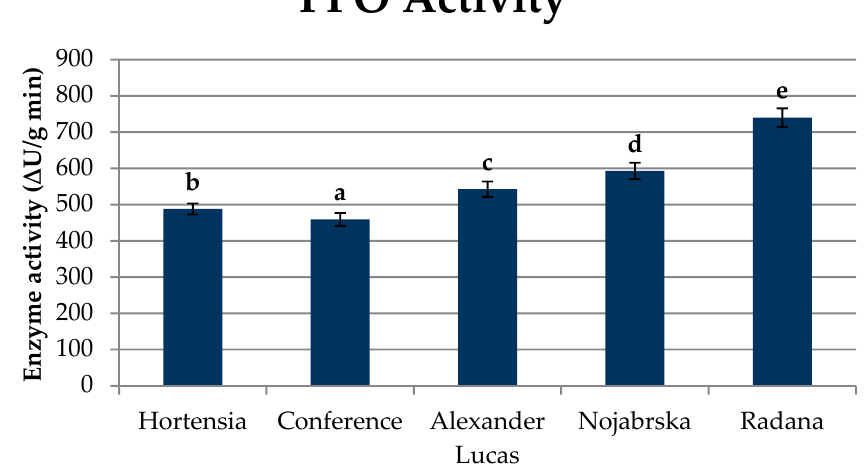
Figure 2. Polyphenol oxidase (PPO) activity ( ∆ U/g min) in pear cultivars. Varieties with different letters were significantly different at p = 0.05 according to Duncan’s test. The data are expressed as mean ± SD ( n = 9).